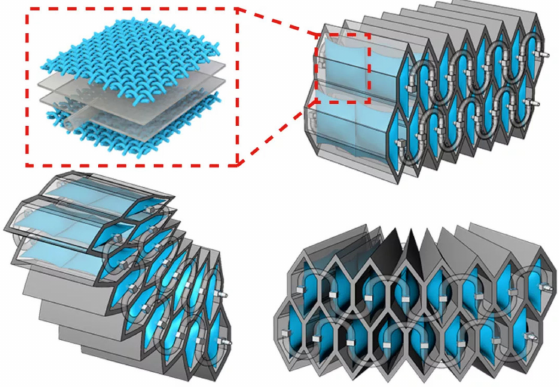
Figure 2. The honeycomb pneumatic networks arm